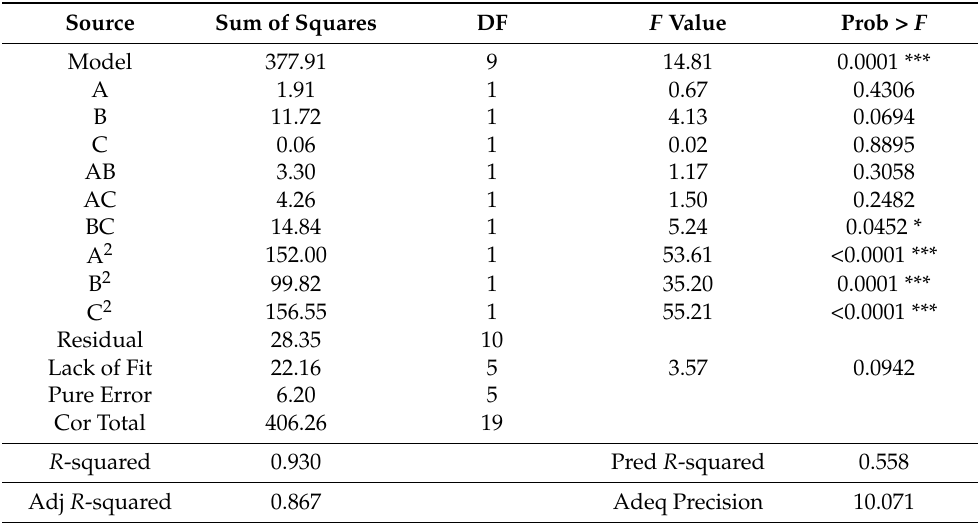
Table 9. Analysis of variance (ANOVA) for central composite data design (CCD) for biosurfactant production using PCO as substrate.